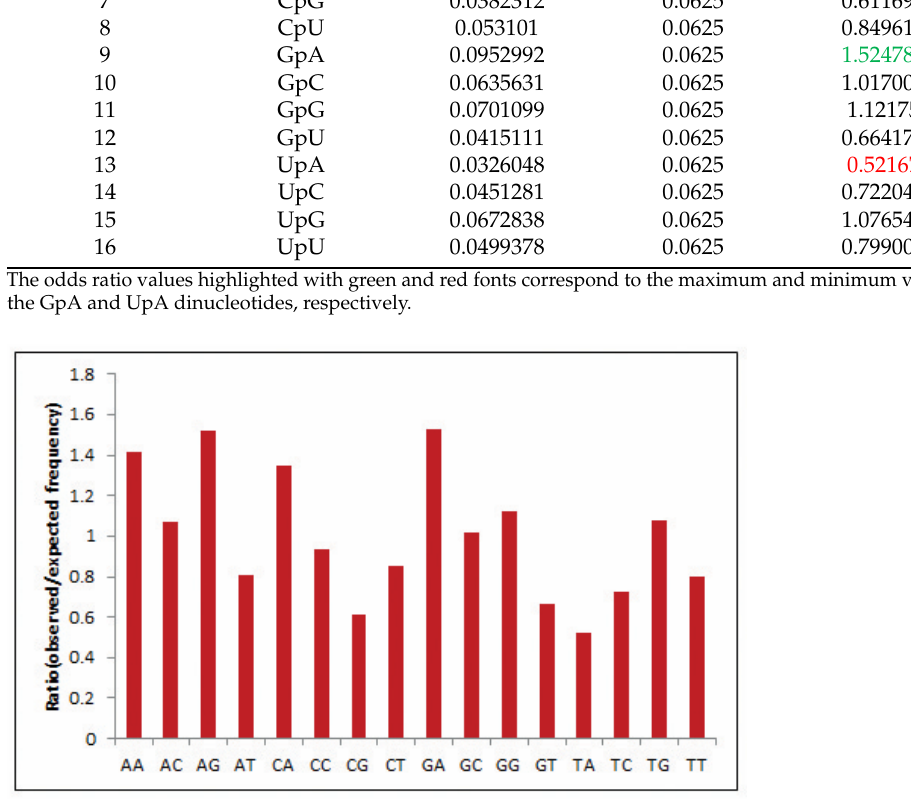
Figure 2. Relative dinucleotide frequencies among the EPB41L3